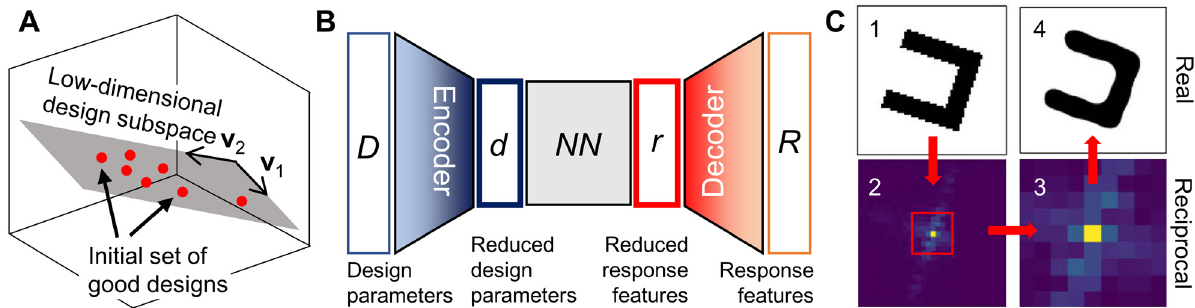
Figure 3: ( A ) A schematic of employing PCA in a three-dimensional design space. PCA reveals the plane where the good designs reside, thus reducingthe dimensionality. Figure adapted from Melati et al. [55]. Licensed under CC BY 4.0. ( B ) Dimensionality reduction with autoencoder. Design parameters and optical response features are encoded into reduced parameters. ( C ) Encoding a two-dimensional geometry into a low dimensionalFourierspace.(1:Originalimage,2:Originalimageinthereciprocalspace,3:Lowdimensionalimageobtainedbyremovinghigh- frequency components. 4: Image recovered from inverse Fourier transforming image in 3). C Figures are adapted with permission from